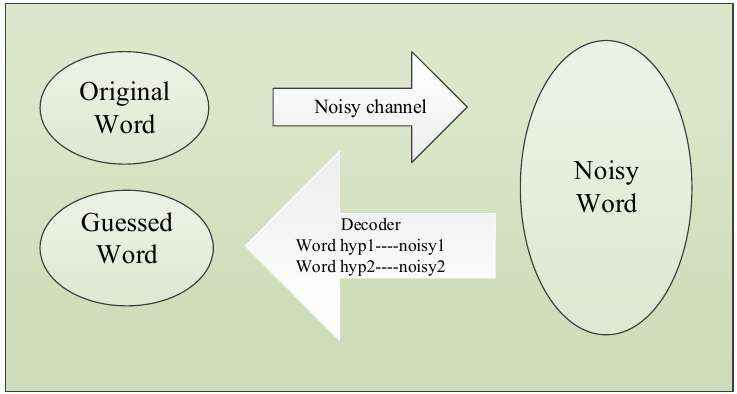
Figure 6. Real-word spelling correction model.